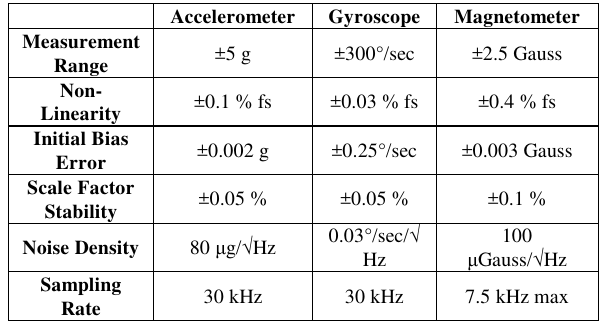
Table 1. Main specifications of Microstrain